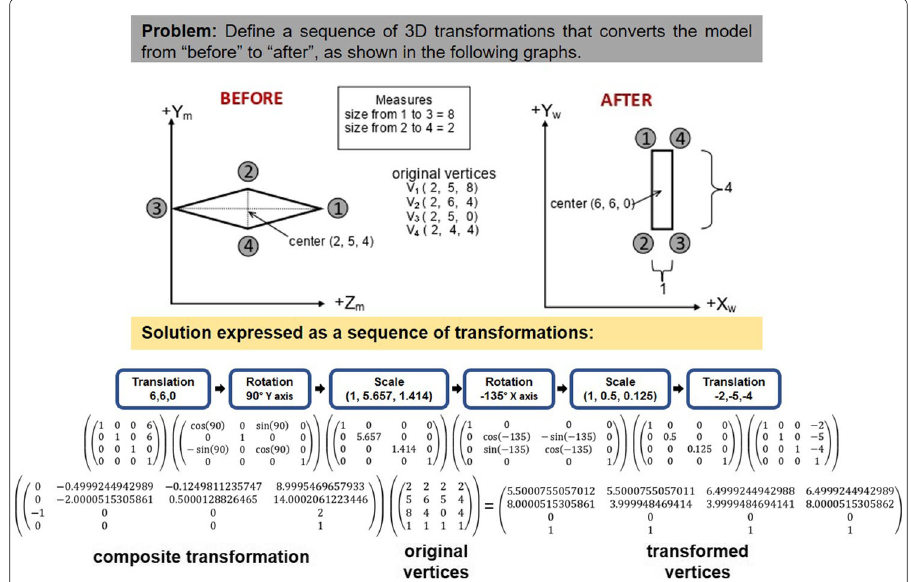
Fig. 6 Example: class assignment of complex sequence of 3D